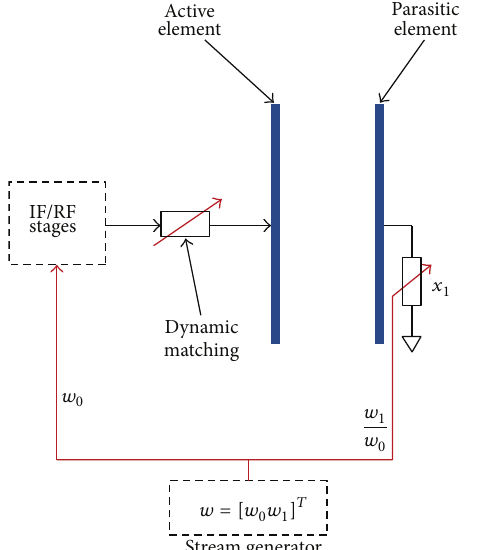
Figure 1: Topology of the proposed single RF MIMO transmission system.